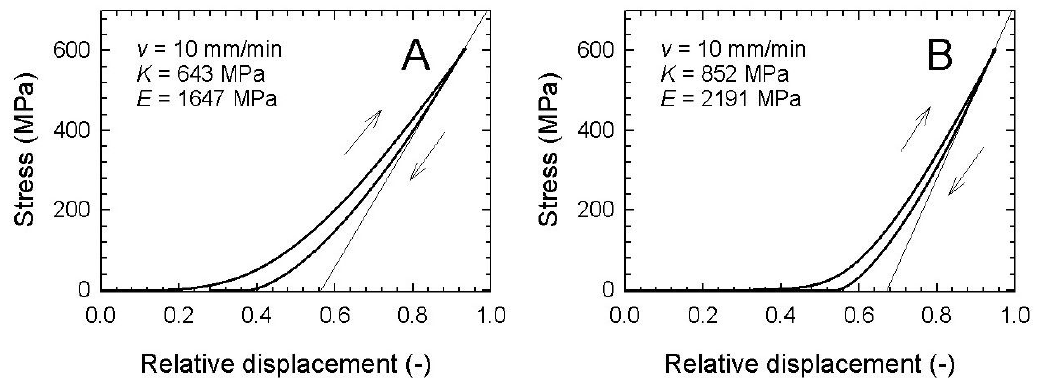
Figure 6: Stress vs relative displacement dependencies observed during chamber uniaxial compression testing (at 10 mm/min deformation rate and 80 kN compression force): A - hollow spheres calcium carbonate filler (sample 1), B - wollastonite filler (sample